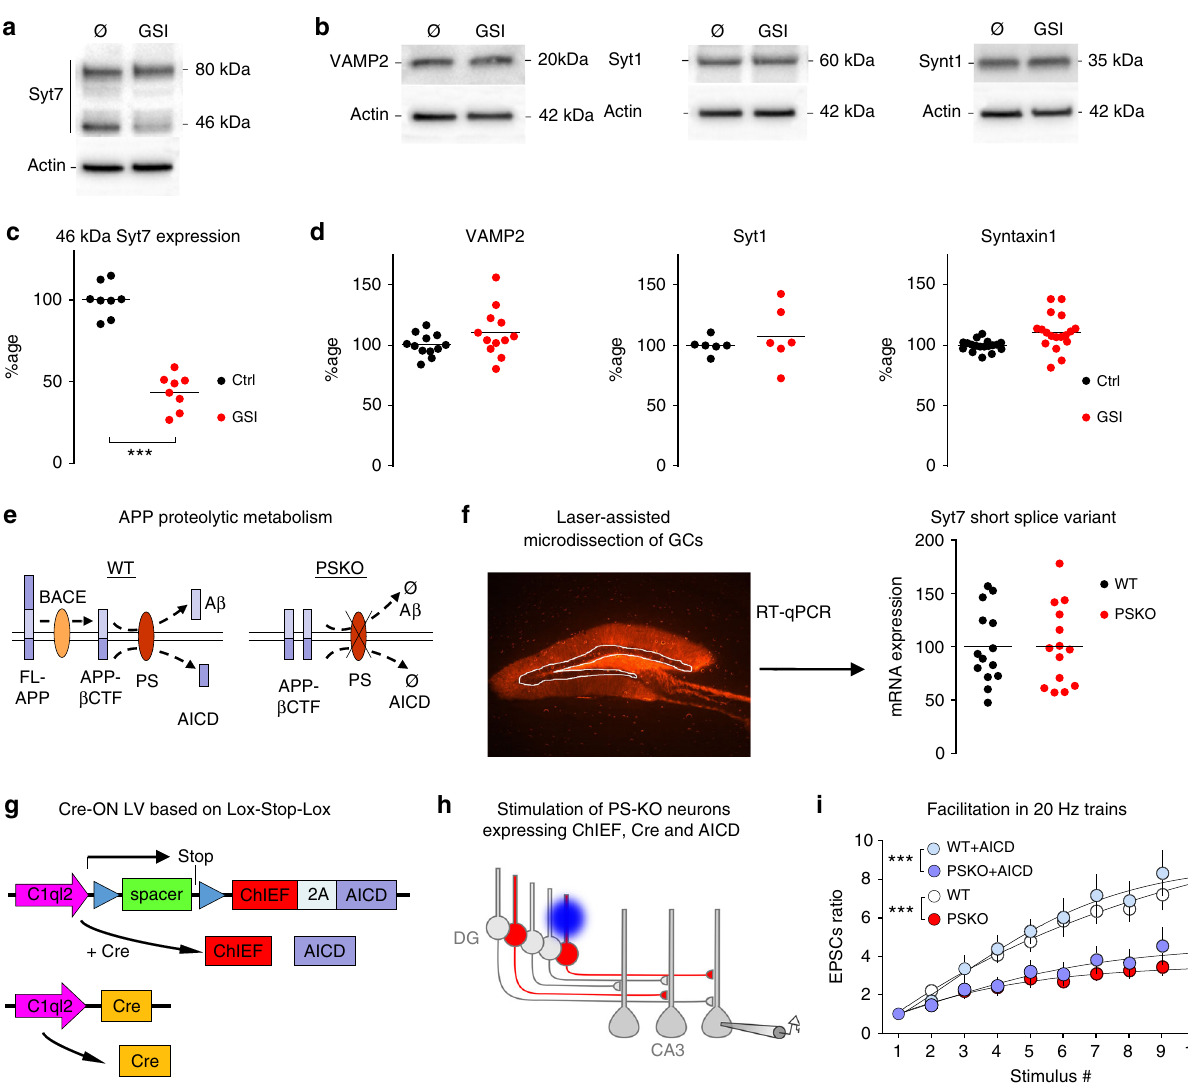
Fig. 5 γ -secretase activity regulates Syt7 protein levels. a , b Western blots of protein samples from neuronal cultures treated or not with 10 µ M GSI from 10 to 14DIV. The 46 kDa Syt7 band decreases dramatically when γ -secretase is inhibited. γ -secretase inhibition does not impair expression of VAMP2, Syt1, and Syntaxin1A. c , d Scatter plots of the western-blot quanti fi cation of samples from neuronal culture treated or not with GSI. Syt7 expression is decreased by half in treated condition as seen in a , while the expression of VAMP2, Syt1, and Syntaxin1A is stable under GSI condition as seen in b . e Schemes of APP proteolytic metabolism in WT and PSKO conditions. Full-length (FL) APP is fi rst cleaved by BACE producing β CTF, a transmembrane stub, further degraded by PS ( γ -secretase) into A β and APP IntraCellular Domain (AICD). In absence of PS, β CTF cannot be catabolized and thus accumulates. f Confocal image of the hippocampus depicting the GCs layer dissected with a laser to prepare RNA samples, and RT-qPCR analysis of the samples indicates that mRNA level of Syt7 is not impaired in absence of PS. g Schemes of the two lentiviruses (LV) used to rescue AICD expression in PSKO GCs controlled by light. C1ql2 promoter restricts the expression of Cre to GCs where the PS fl oxed gene is deleted. The Cre also removes the Lox-Stop-Lox sequence allowing the Cre- ON LV to express AICD and ChIEF. h Strategy to selectively study Mf/CA3 synapses that are presynaptically PSKO, yet express AICD. In PS “ fl oxed ” conditional knock-out mice, double-infected GCs do not express PS (Cre deletes PS fl gene), yet express AICD (Cre dependently), and ChIEF (bicistronic construct) allowing the control of their activity by light. GCs infected by a single virus do not respond to light. i Facilitation of EPSCs amplitude measured along trains of 10 stimuli at 20 Hz in WT or PSKO-expressing AICD. The impaired facilitation of PSKO is not rescued by expression of AICD. Two-way ANOVA, n = 8 in WT, 11 in PSKO, p = 0.017. Errors bars represent